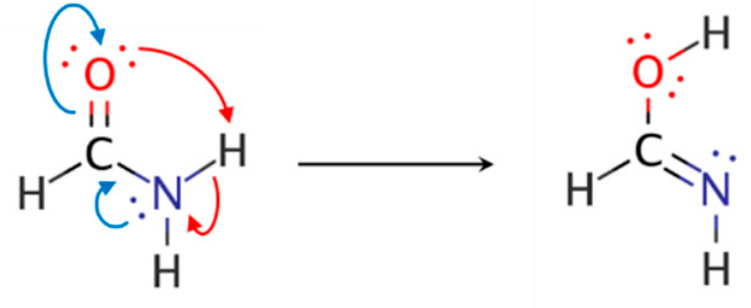
Figure 8. Curly-arrow depiction of resonance-type electronic delocalizations in formamide Figure 8. Curly ‐ arrow depiction of resonance ‐ type electronic delocalizations in formamide tau ‐ tomerization.